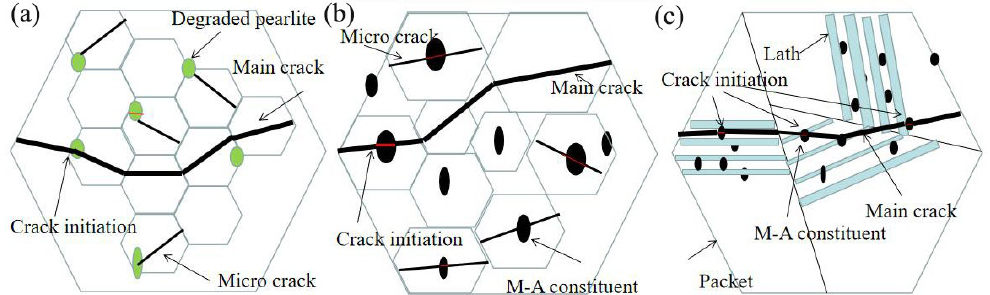
Figure 11. Local misorientation distribution map and the local misorientation frequency distribution: ( a , d ) S1, ( b , e ) S2, and ( c , f ) S3.